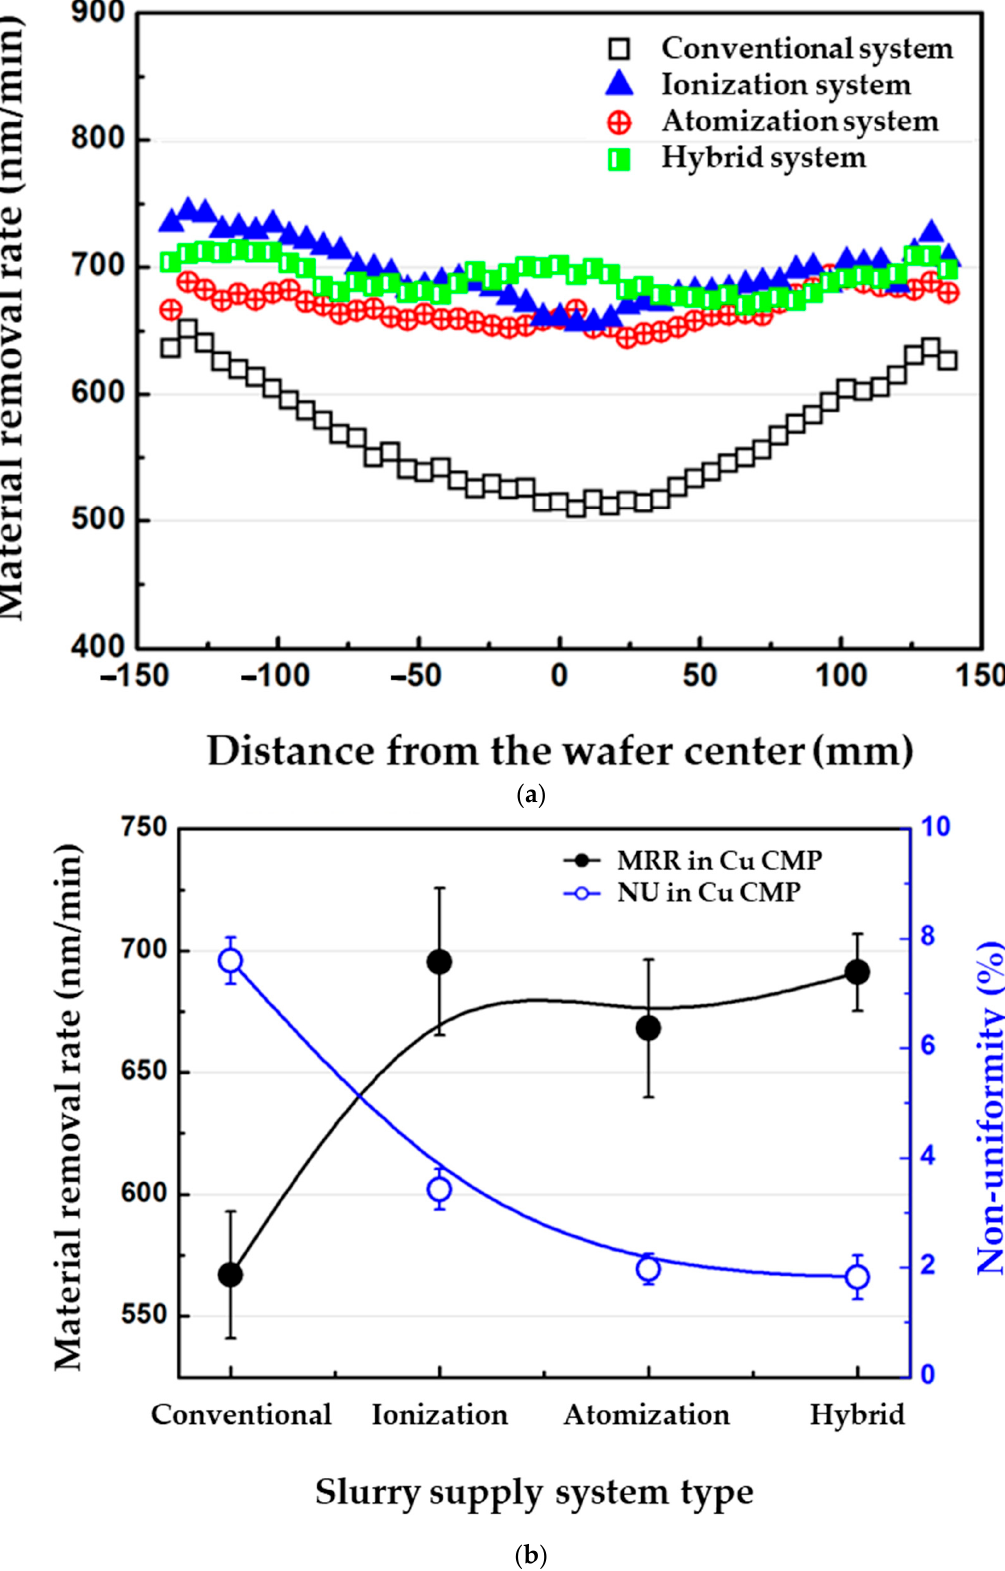
Figure 5. 300-mm Cu non-patterned wafer (NPW) CMP results based on the types of slurry supply system. ( a ) MRR profiles and ( b ) average MRR and NU.